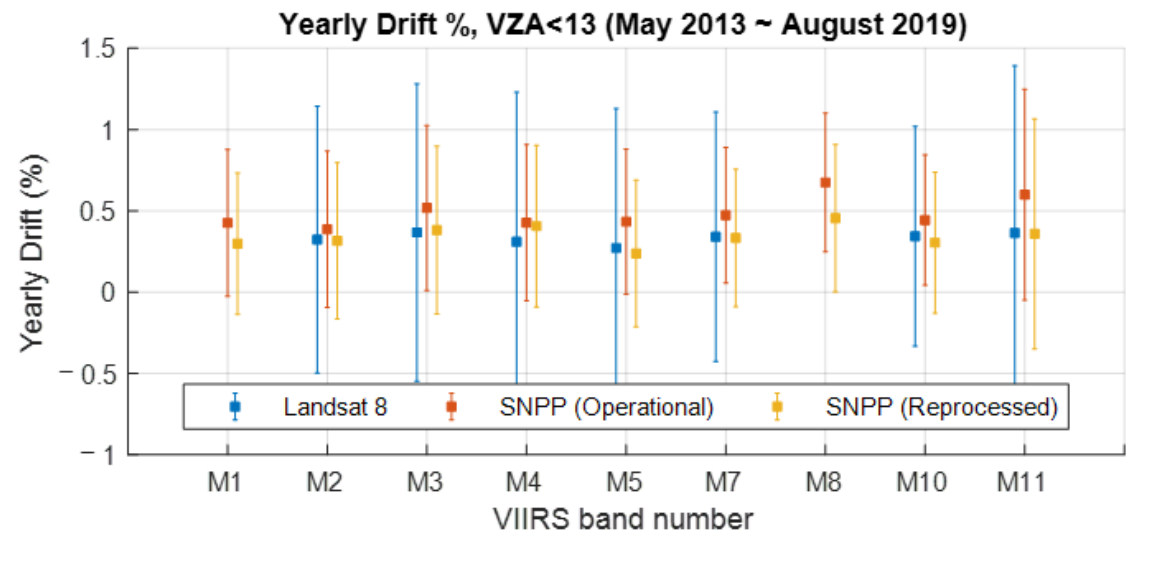
Figure 8. The yearly drift and its 95% confidence interval of the reflectance ratio between RadCalNet with Landsat 8/OLI (blue), operational (red), and reprocessed (orange) SNPP/VIIRS at RVUS from May 2013 to August 2019. Table 5. The yearly drift and its 95% confidence interval of the reflectance ratio between RadCalNet with Landsat 8/OLI, operational, and reprocessed SNPP/VIIRS at RVUS from May 2013 to August 2019, and the drift difference between operational and reprocessed SNPP/VIIIRS and